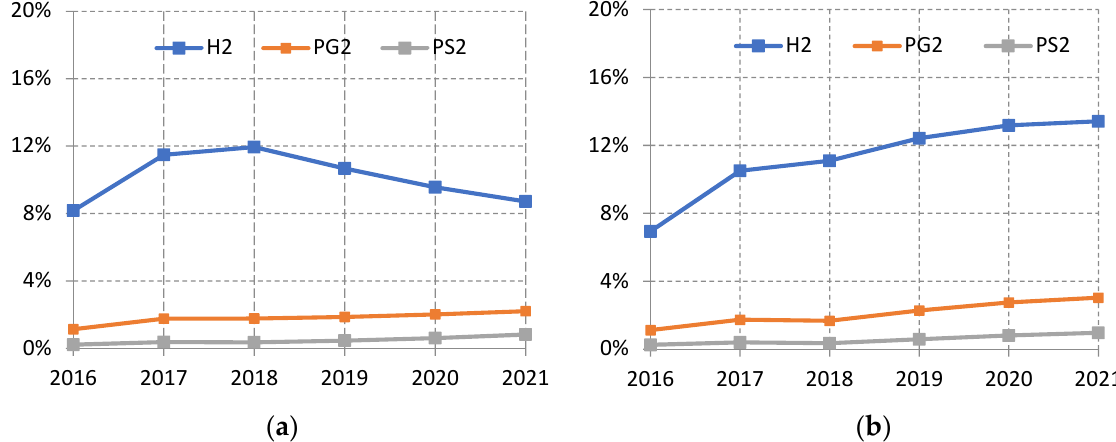
Figure 3. Intertemporal calculations of relative poverty: ( a ) rural resettled; ( b ) urban resettled.